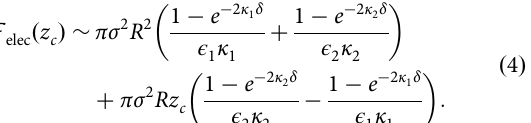
Fig. 3 Phase diagram for an RNA virus approaching liquid – liquid interfaces. Phase diagram showing the fate of a viral particle approaching an interface between a physiological aqueous medium and another medium with variable electrostatic parameters. The heat map shows the adsorption free energy, Δ F ads , in units of k B T , which includes both the electrostatic and Pickering contribution. The dashed line shows the location of the phase boundary between the phase where the system free energy is minimised with the virus in the aqueous phase (internal, z c < − R ) or at the interface (adsorbed, z c > − R ). Parameters are as in Figs. 1 and 2, except for γ , which is now 1.5 mN/m to model the lower surface tension of liquid – liquid contact angle (Fig. 1a) of θ ~ π /3 (or to z c / R ≃ − 0.5). The nontrivial θ ( ≠ 0 or π /2) is due to the different scaling of the electrostatic and Pickering free energies with z c : the former is approximately linear (Fig. 2a), the latter quadratic (Eq. (3)).